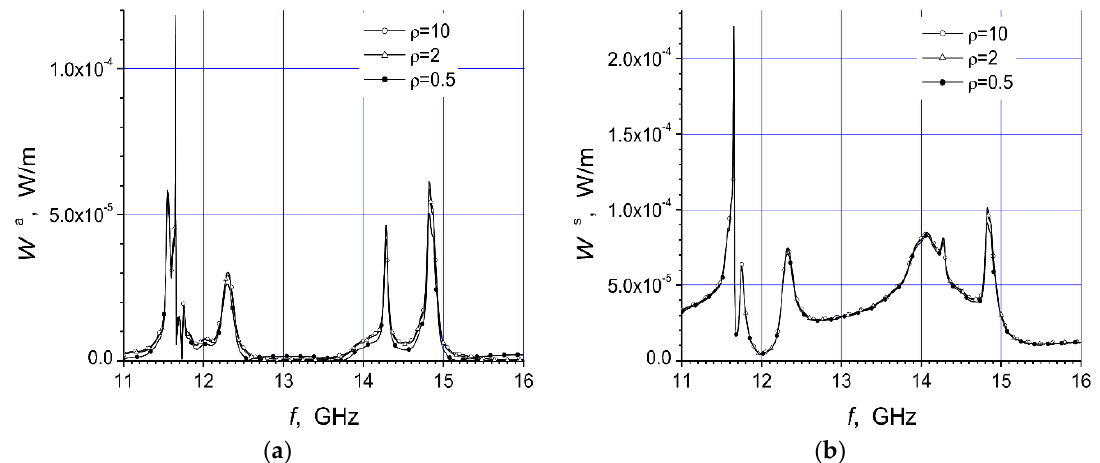
Figure 7. Dependencies of absorbed power ( a ) and scattered power ( b ), of the array Figure 1b, on the frequency of the perpendicular polarized incident wave at R = 12 mm.